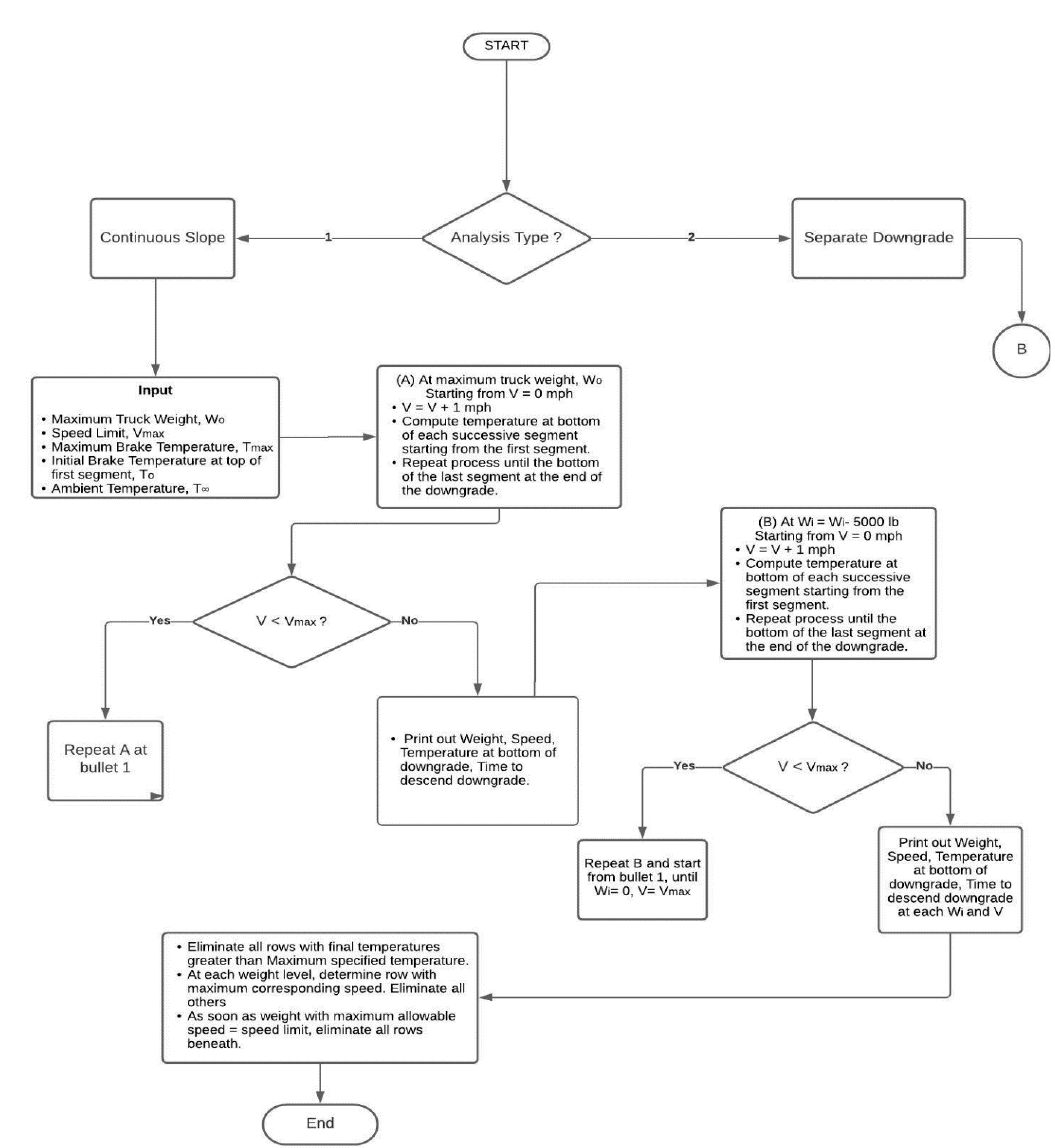
Figure 1: Process flow chart for continuous slope